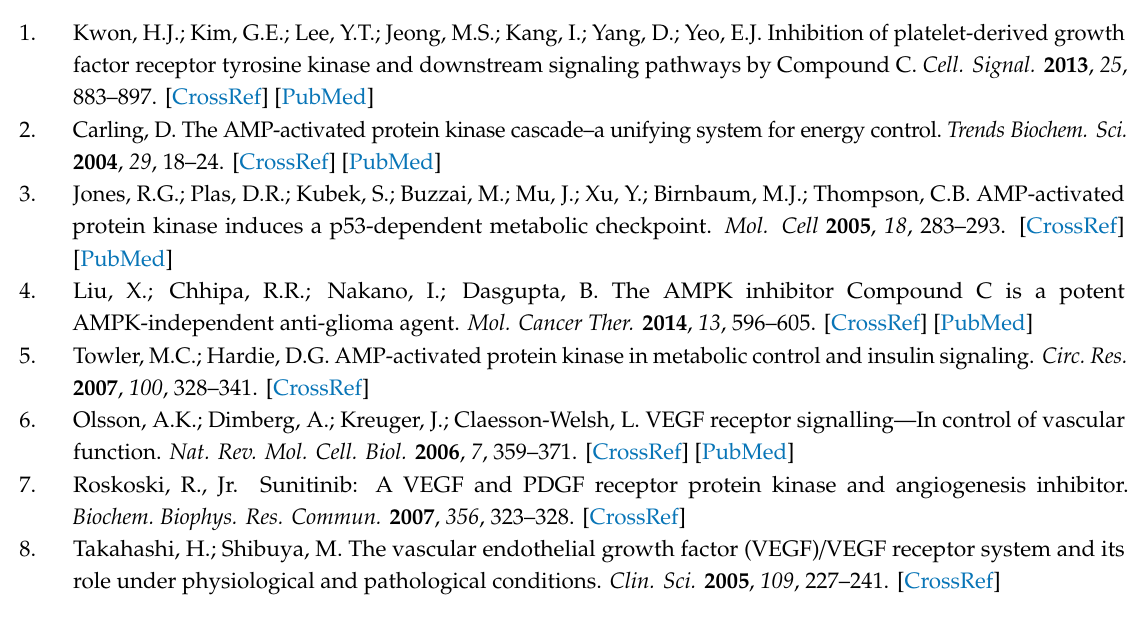
Figure S1: Quiescent cells were stimulated with 10% FBS for the indicated times (8, 16, and 24 h) in the presence of vehicle ( − ) or 10 µ M CompC ( + ), Figure S2: B16-F1 cells were transfected with mock or AMPK α 1 / 2 siRNA for 48 h and then stimulated with 10% FBS in the presence of vehicle ( − ) or 10 µ M CompC ( + ) for 16 h, Figure S3: B16-F1 cells were stimulated with 10% FBS for the indicated times in the presence of vehicle or 10 µ M CompC, Figure S4: B16-F1 cells were serum-starved by incubation with SFM for 24 h, Figure S5: HUVECs were serum-starved by incubation with EBM for 24